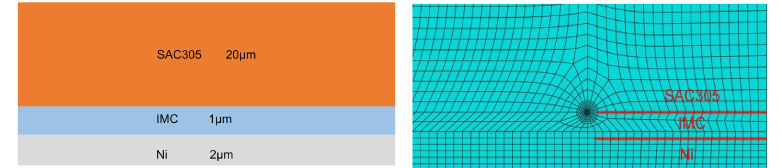
Figure 4. Model for calculating the stress intensity factor under different crack